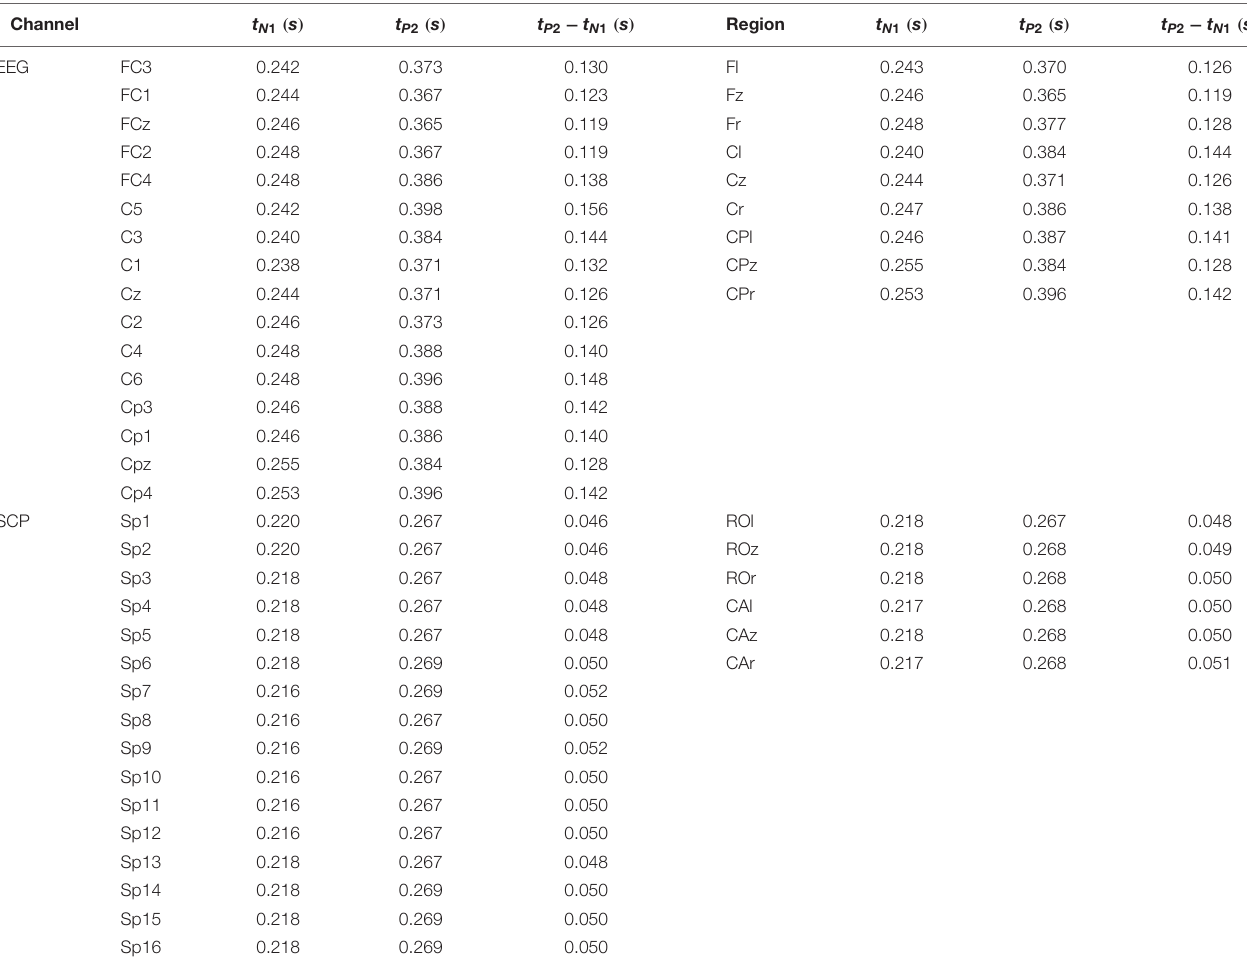
TABLE 1 | Average time (from t = 0 s is the stimulation onset) until the N1 wave and P2 wave peak.